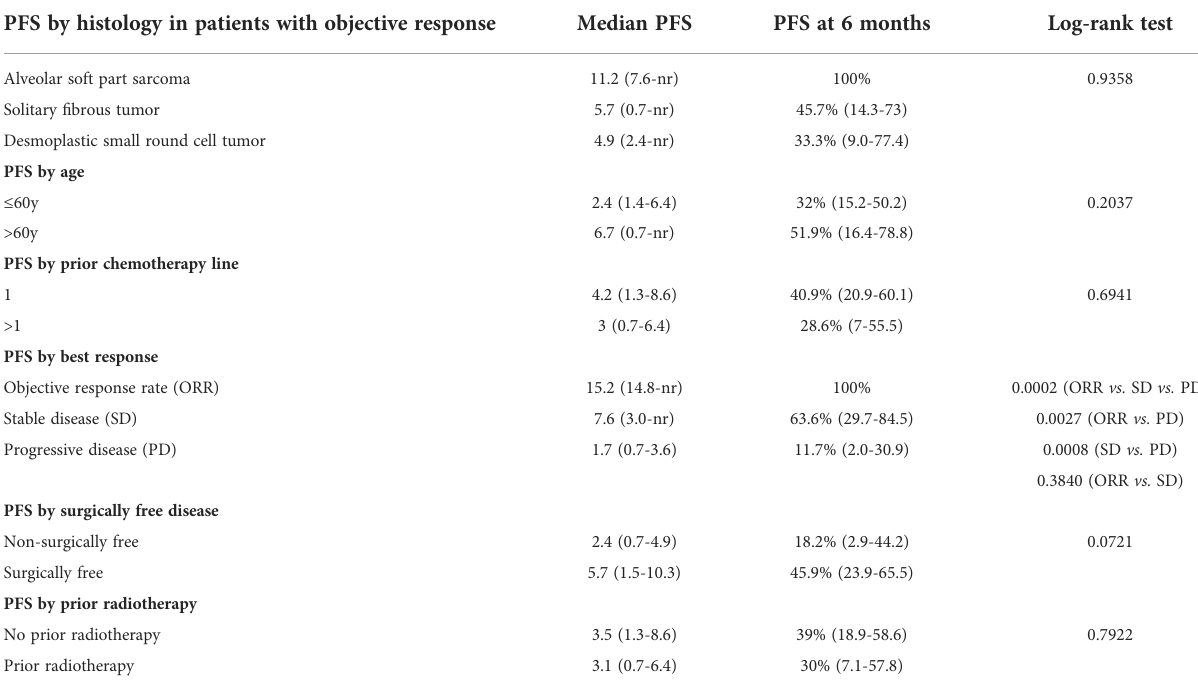
TABLE 3 Univariate analyses of progression-free survival. Univariate analyses of Progression-free survival (PFS) PFS by histology in patients with objective